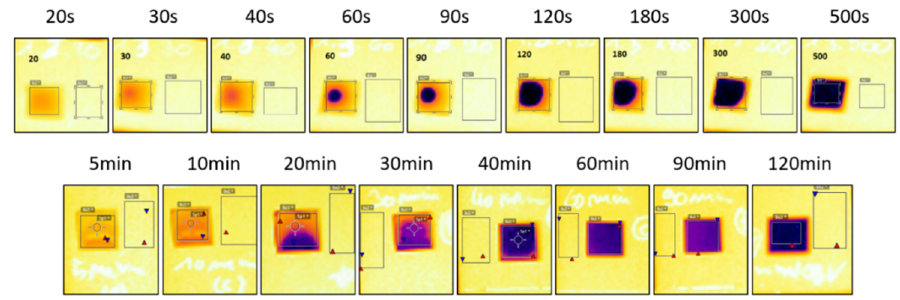
Figure 5. (E40) thermal images of the emissivity progression during sintering. Top row; NIR sintered JS-B40G. Bottom row; oven sintered JS-B40G. Dark areas have low emissivity; yellow areas have high emissivity.